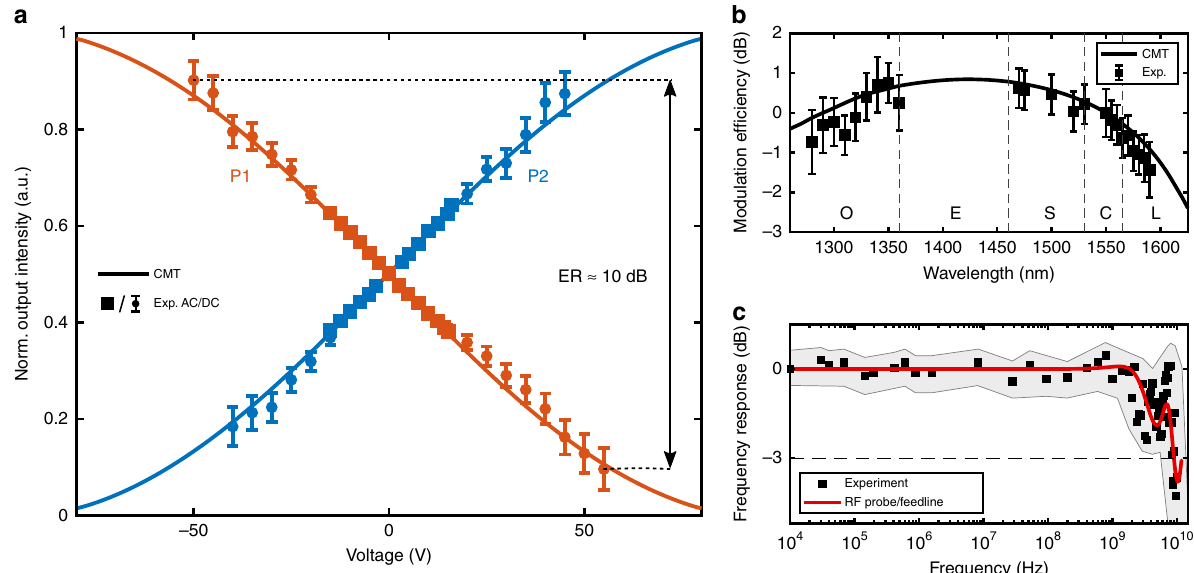
Fig. 4 Directional coupler switch characteristics. a Measured (symbols) and simulated (solid lines) electro-optical transfer function, showing the power exchange as a function of the applied bias voltage. Error bars represent standard deviations and are deduced from repeated measurements. For AC signals smaller than 15 V (with a frequency of 200 kHz), error bars are smaller than the symbols. b Wavelength dependence of the modulation ef fi ciency (at the driving voltage of 15 V) normalized by that measured at the design wavelength of 1550 nm. Less than 2 dB modulation deterioration over all optical communication wavelength bands is observed. Error bars indicate the estimated standard deviation of the mean. c Measured frequency response as a function of the applied RF signal frequency, normalized with respect to the lowest applied frequency. The continuous shaded error region represents the standard deviation in the measured frequency response with a smoothed average between data points. The response in the measured frequency range is only restricted by the bandwidth limitations of the RF probe and the electrical feedline (red